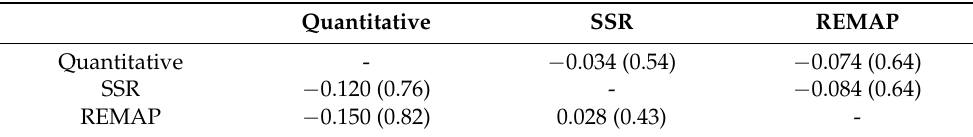
Table 5. Pairwise comparison of molecular and morphological data. Numbers in parentheses indicate p -value (Mantel test). The results below (respectively, above) the diagonal indicated the correlation coefficient between the distance matrices (resp. the cophenetic value matrices). Quantitative SSR REMAP Quantitative - − 0.034 (0.54) − 0.074 (0.64) SSR − 0.120 (0.76) - − 0.084 (0.64) REMAP − 0.150 (0.82) 0.028 (0.43)